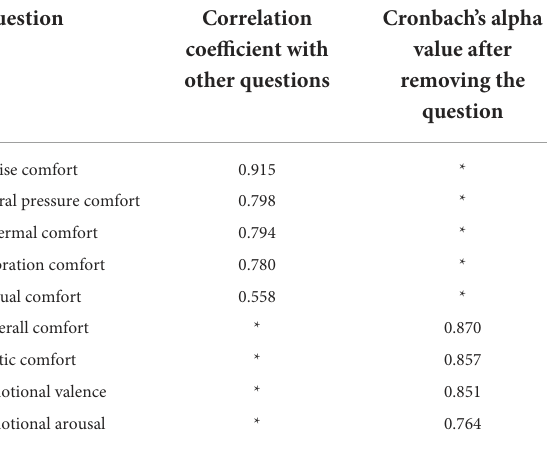
TABLE 2 Results of intrinsic reliability analysis of subjective comfort questionnaire.